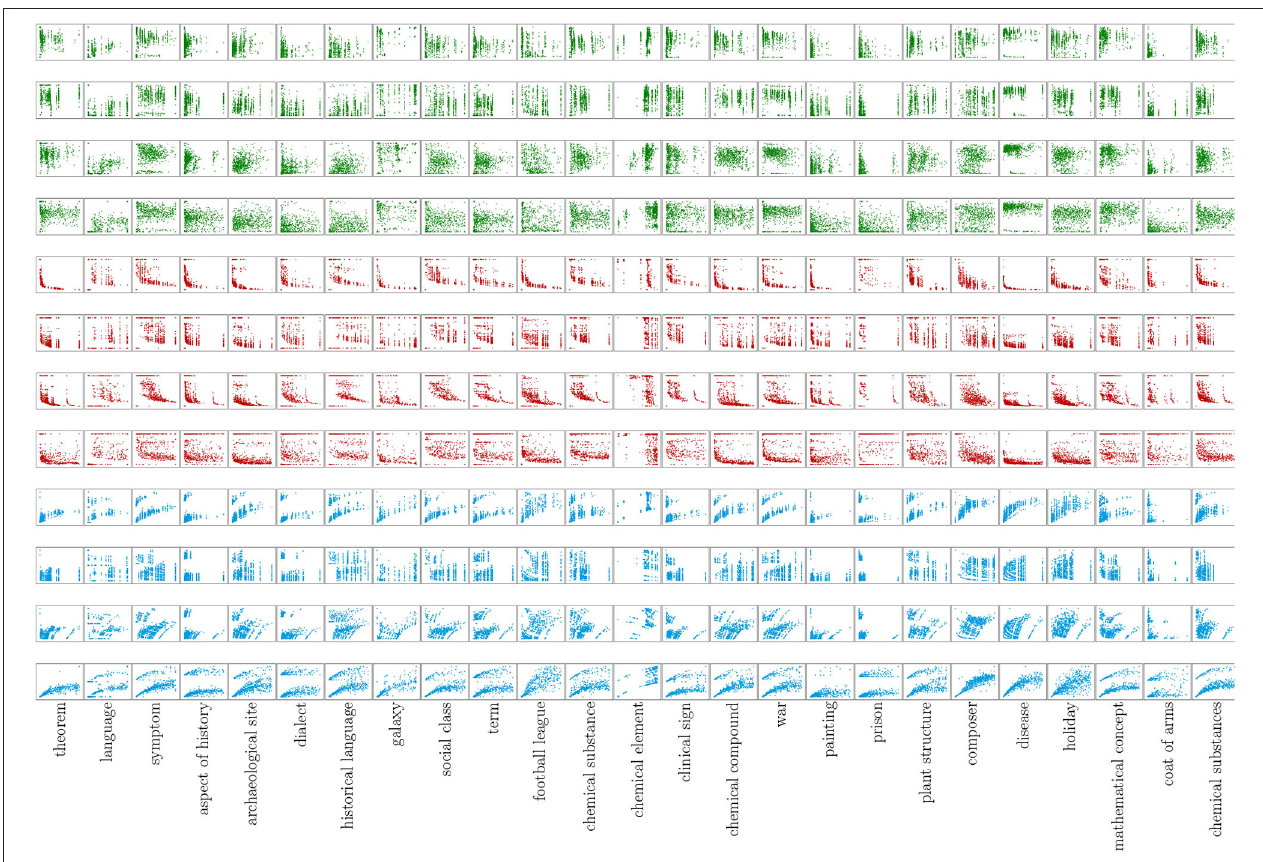
FIGURE 9 | Similarities of languages as a function of the size (number of vertices) of the networks (INs) involved. Four alternatives of calculating the size s ( I x i , I x j ) of pairs ( I x i , I x j ) of network: 1st row: s ( I x i , I x j ) = min( | V x i | , | V x j | ), 2nd row: s ( I x i , I x j ) = max( | V x i | , | V x j | ), 3rd row: s ( I x i , I x j ) = | V x i | + | V x j | and 4th row: s ( I